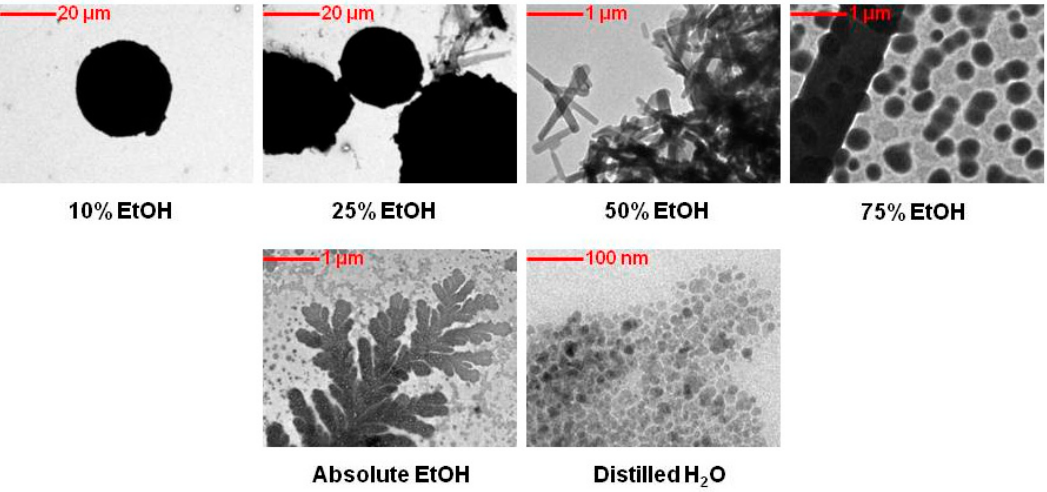
Figure 1. Transmission electron microscopy (TEM) images of benzyl (2 α , 3 β ) 2,3-diacetoxy-olean − 1 2- en-28-amide (EM2).